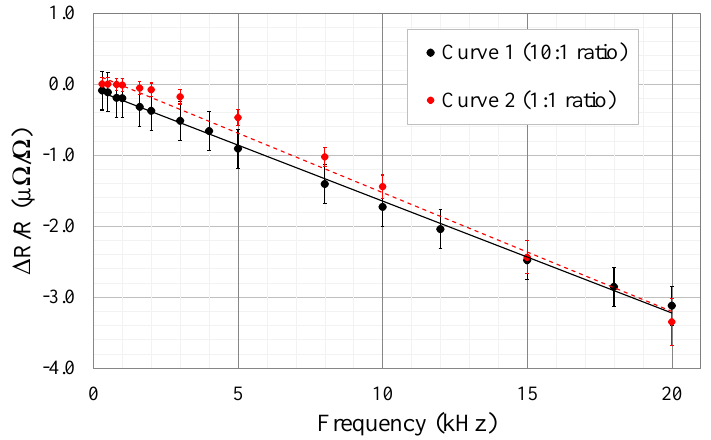
Figure 11. Graph of the relative difference between the measured and the calculated frequency dependence of the equivalent parallel resistance of CR-1k-D, as a function of frequency. Curve 1 using the CR-10k-D5e as reference (ratio 10:1, black points), Curve 2 using the Haddad1000 1201 as reference (ratio 1:1, red points)